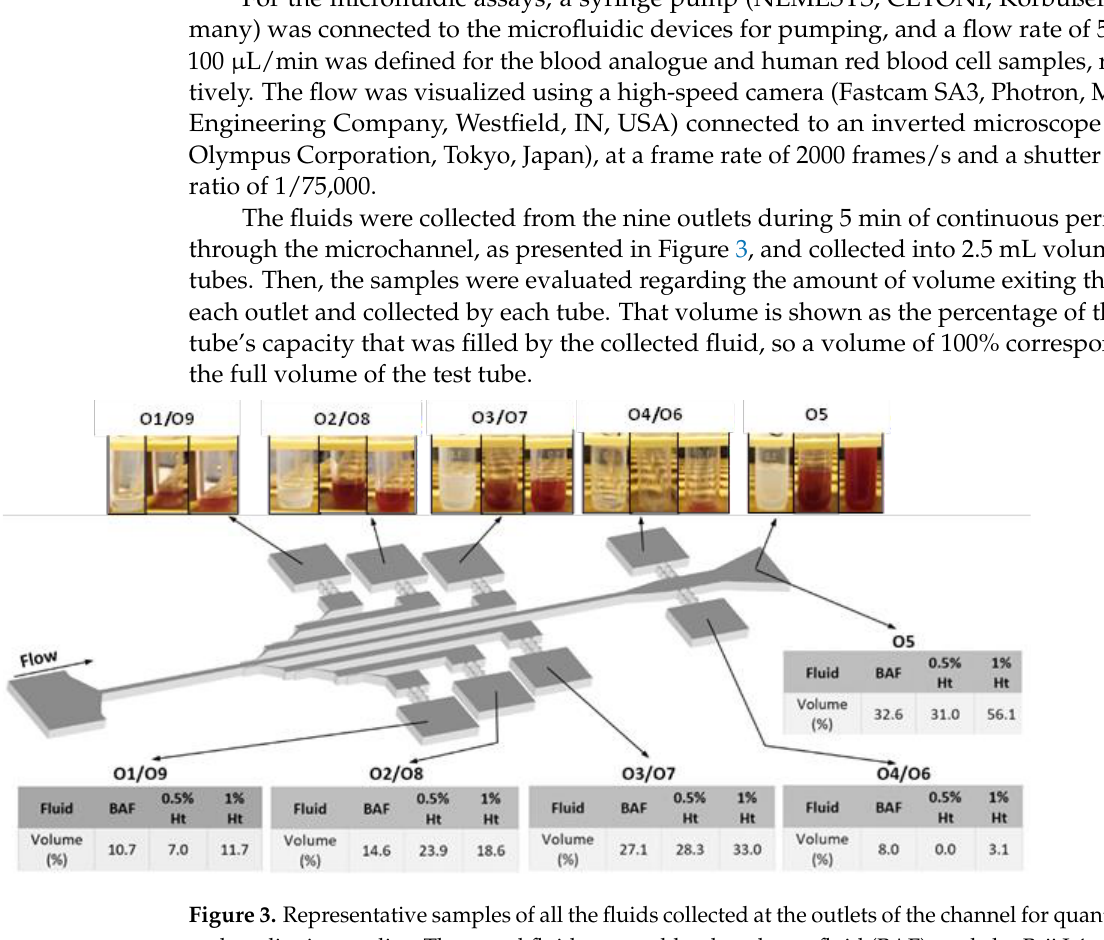
Figure 3. Representative samples of all the fluids collected at the outlets of the channel for quantitative and qualitative studies. The tested fluids were a blood analogue fluid (BAF) made by Brij L4 micelles and a solution prepared from human blood samples with hematocrits (Ht) of 0.5 and 1%. The volume collected is presented as the percentage of a test tube capacity that was filled.